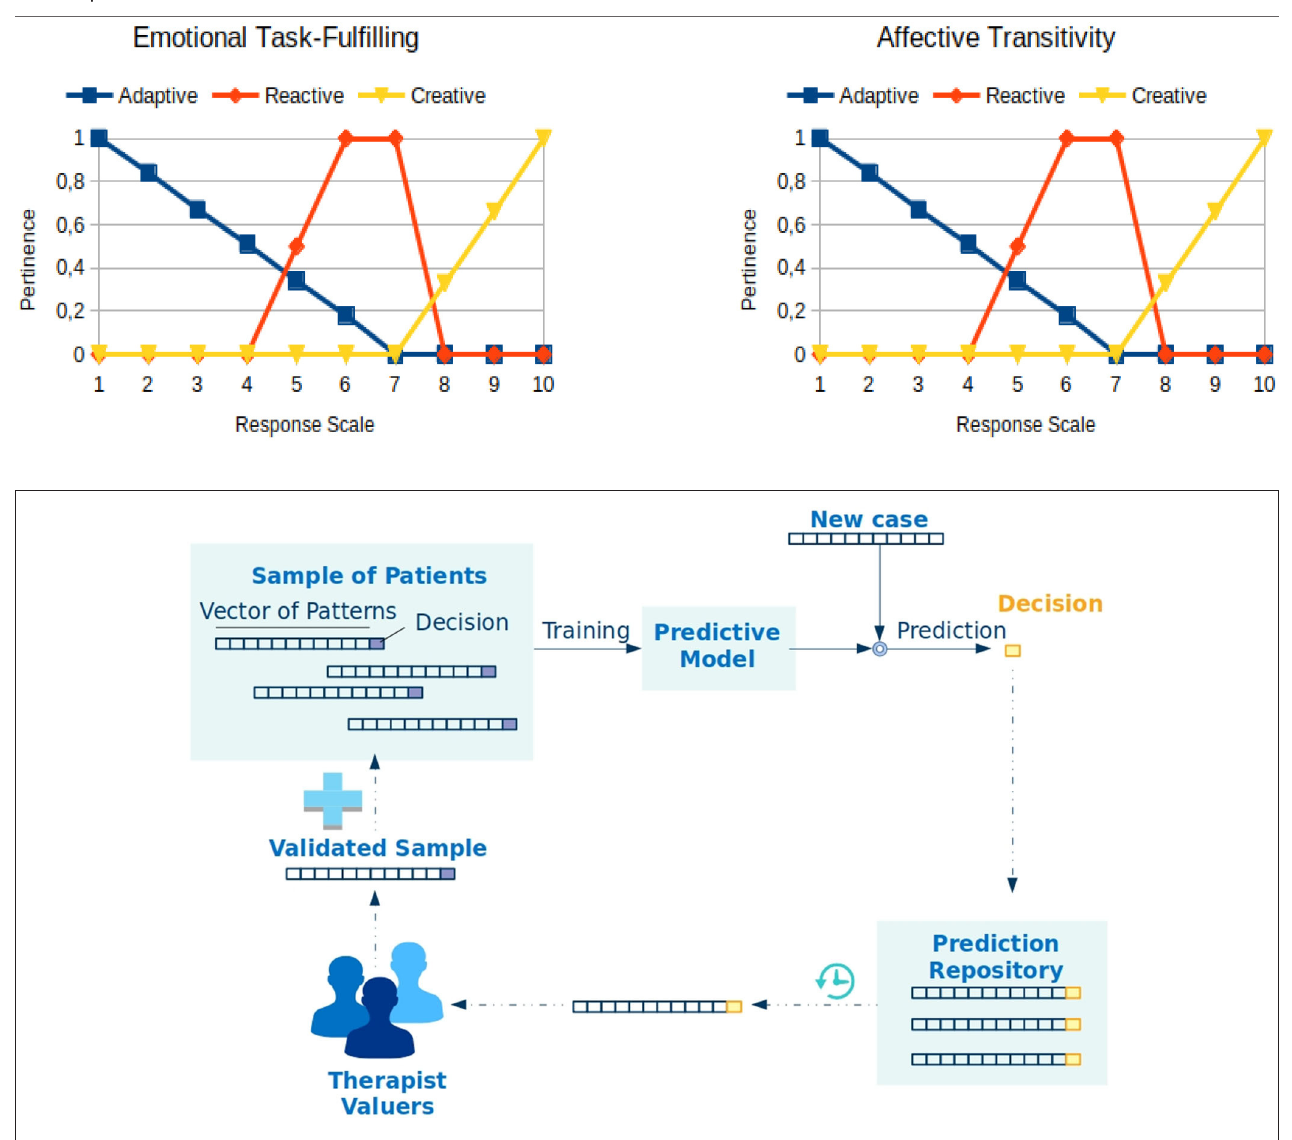
FIGURE 1 | The iterative process of machine learning and inference of patient